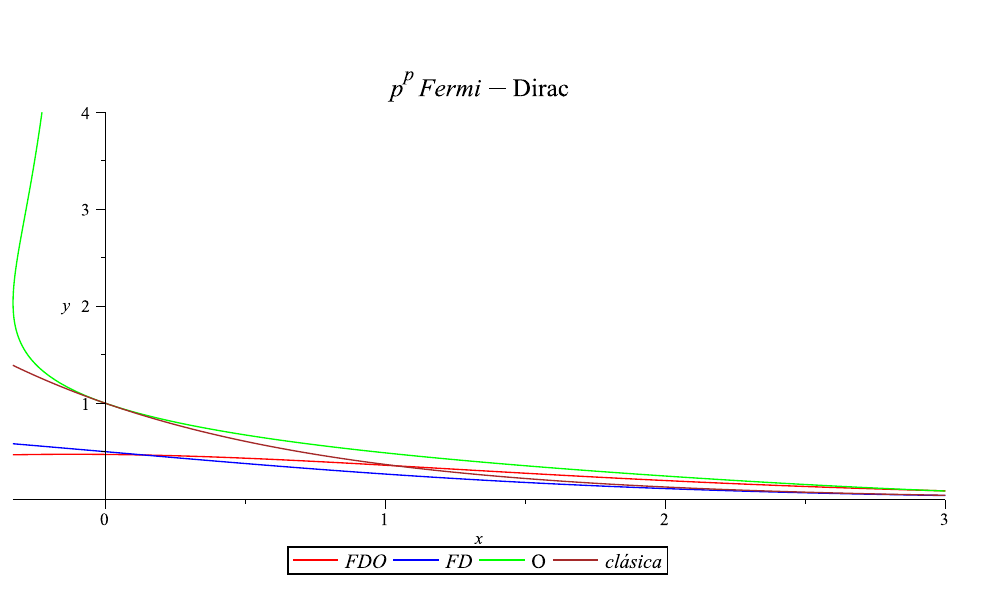
), and classical p l = e − β E l with g I ( β E ) , brown line to classical l I